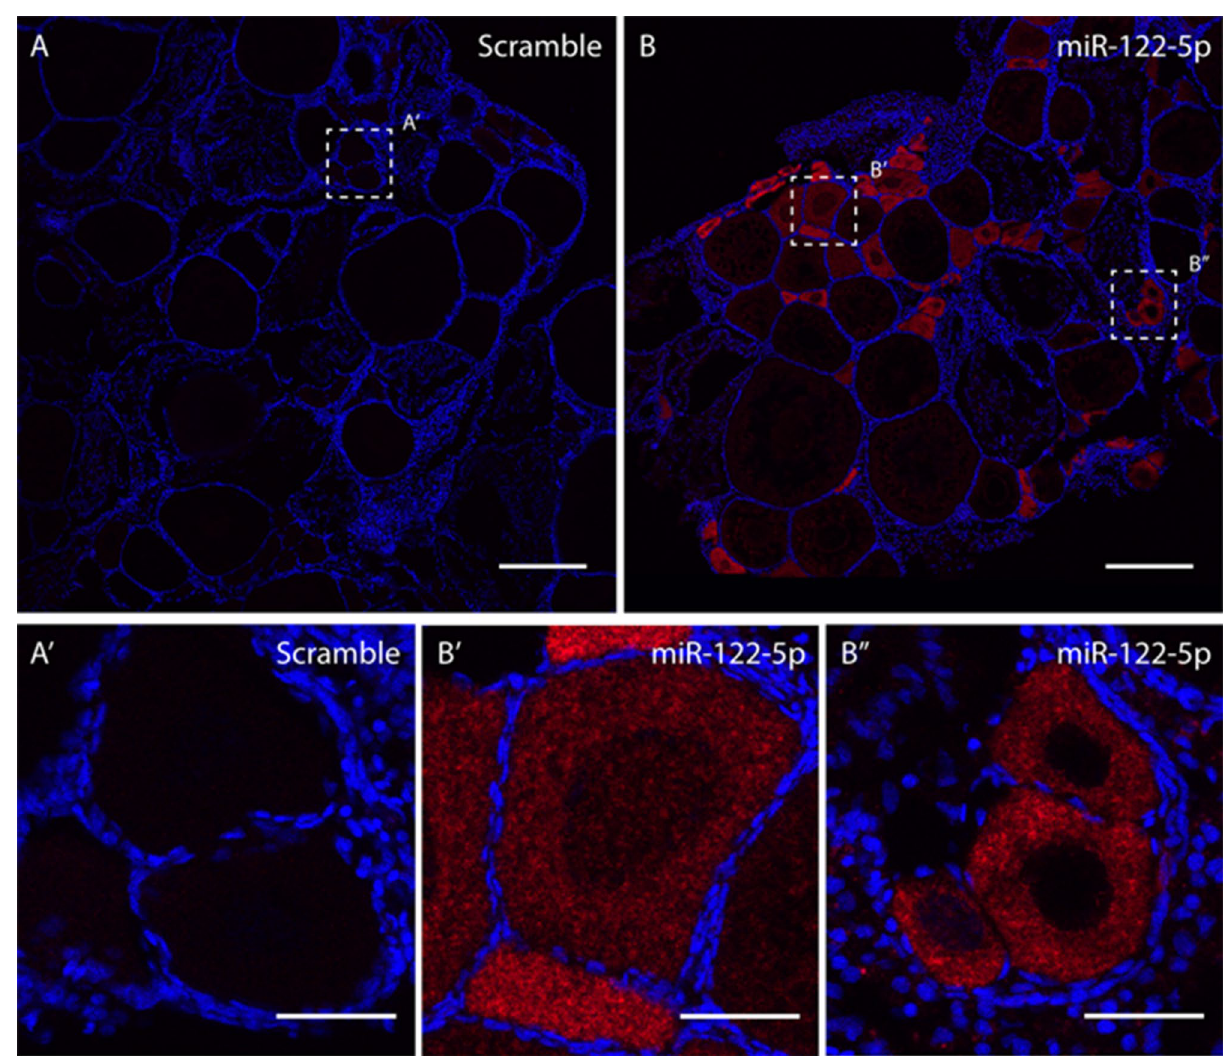
Figure 7. Fluorescent in situ hybridization (FISH) of dre-miR-122-5p in the ovary of adult zebrafish. A total of 6 female fish were used to obtain the results. Sections A and A ′ showed scramble probe. Section B, B ′ and B ″ showed the localization of dre-miR-122-5p in germ cells. (V) Vitellogenic oocyte, (LV) Late vitellogenic oocyte. A and B scale bar = 500 µm and A ′ , B ′ , B ″ size bar = 100